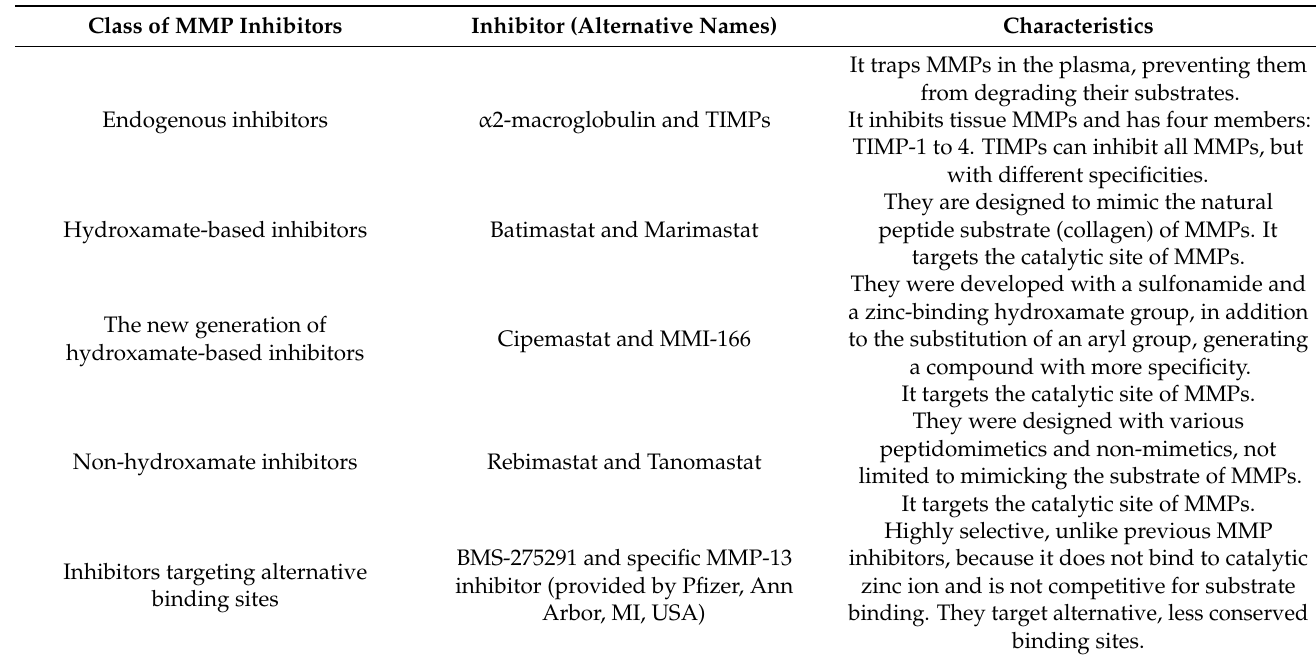
Table 3. Development of MMP inhibitors and their